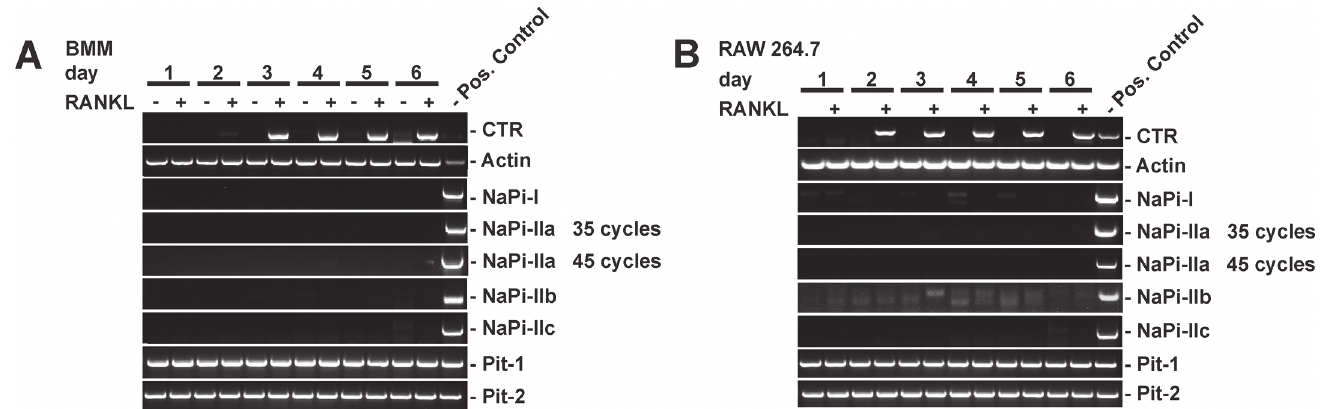
Fig 1. Expression of type I, II, and III phosphate transporter isoforms during osteoclast differentiation studied by endpoint RT-PCR. A) Primary bone-marrow-derived monocytes (BMMs) or B) RAW 264.7 cells were cultured with (+) or without (-) RANKL for 6 days. Total RNA was extracted and cDNA amplified by endpoint-RT-PCR using previously validated, specific primers for type I, type II (IIa, IIb, IIc) and type III (Pit-1, Pit-2) phosphate transporters. Calcitonin receptor (CTR) was used as a maker of differentiation to osteoclasts, β -actin was used as a positive RT-PCR control. Unless otherwise indicated, PCR was performed for 35 cycles. Positive controls were kidney cDNA with the exception of NaPi-IIb, where lung cDNA was